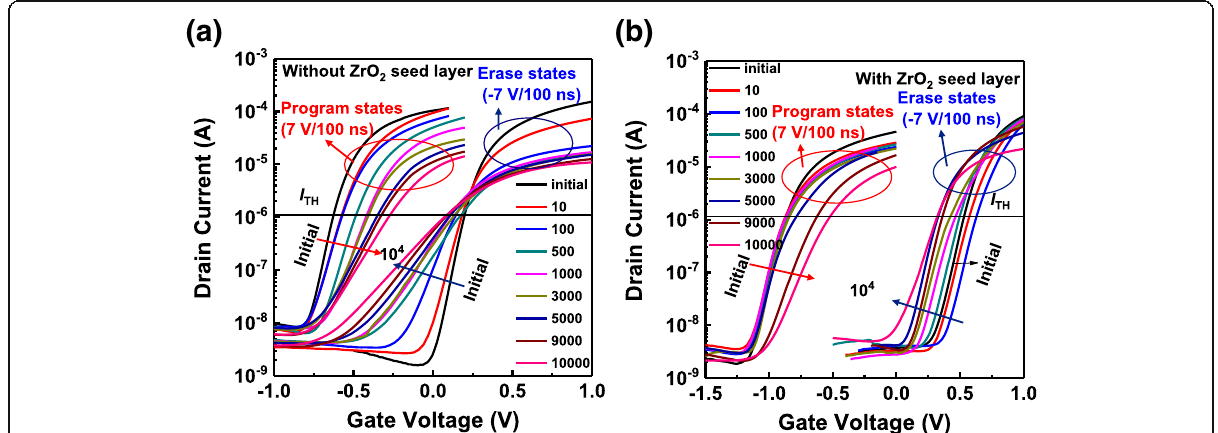
Fig. 4 Evolution of I D – V G curves of HZO-based FeFETs a without and b with ZrO 2 seed layers with P/E cycling